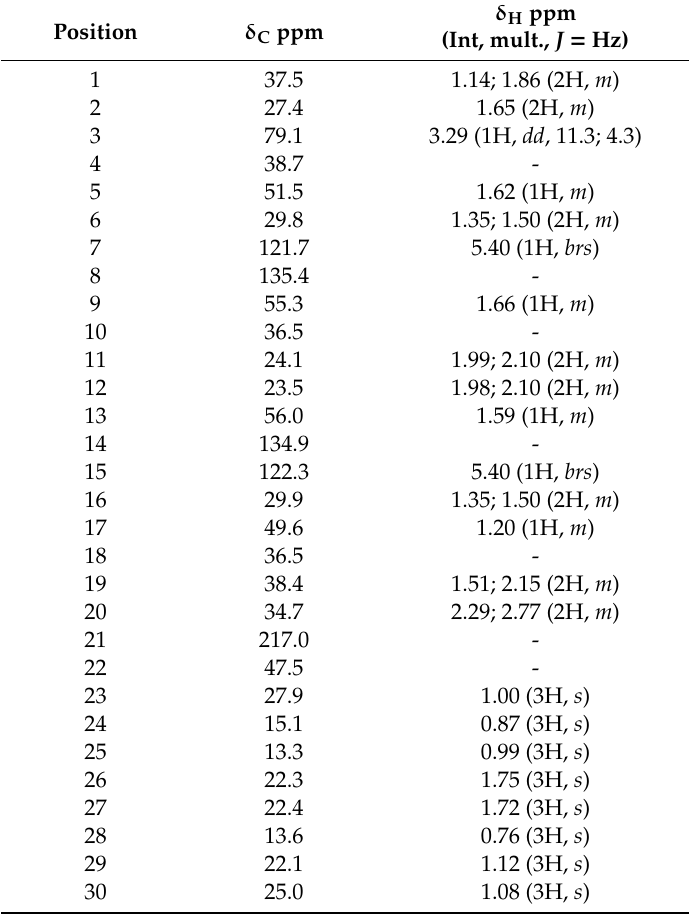
Table 1. 13 C and 1 H NMR Spectral Data of Compounds 1 in CDCl 3